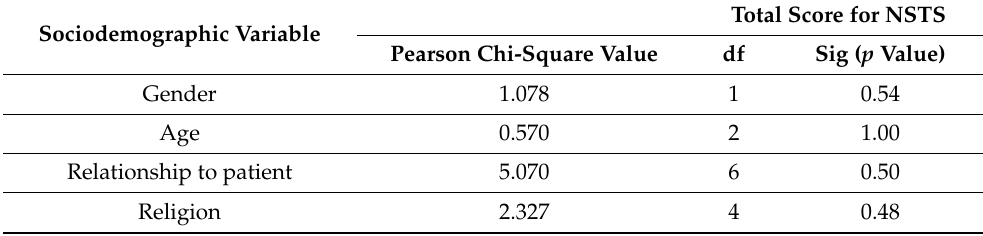
Table 4. Associations between sociodemographic variables and total scores in the